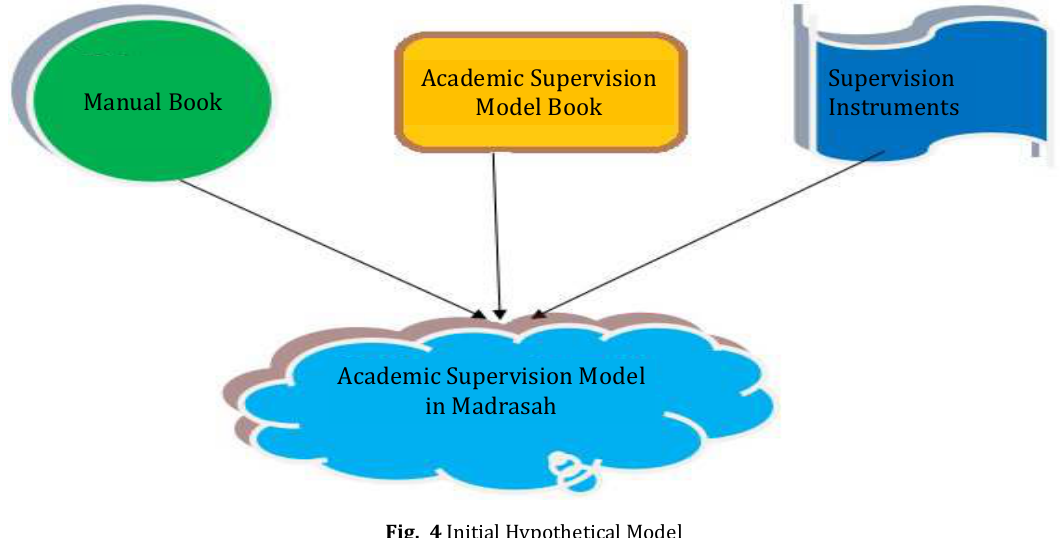
Fig. 4 Initial Hypothetical Model